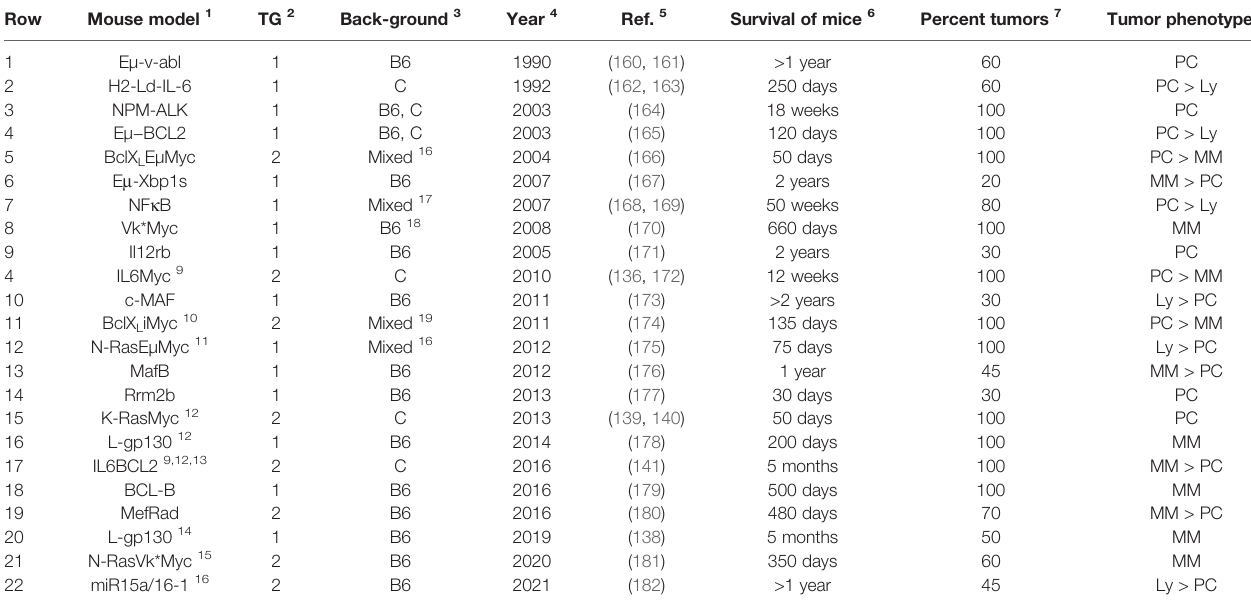
TABLE 1 | Transgenic mice prone to spontaneous plasma cell tumors recapitulating hallmarks of human plasma cell neoplasms including multiple myeloma.